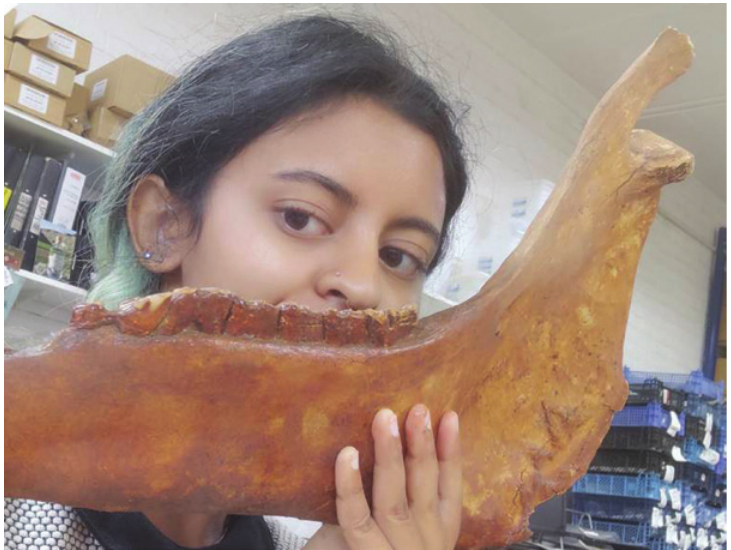
Figure 3 IoA student Neehaarika Jayanth Veena on placement with Archaeology South-East. (Image credit: Archaeology South-East)